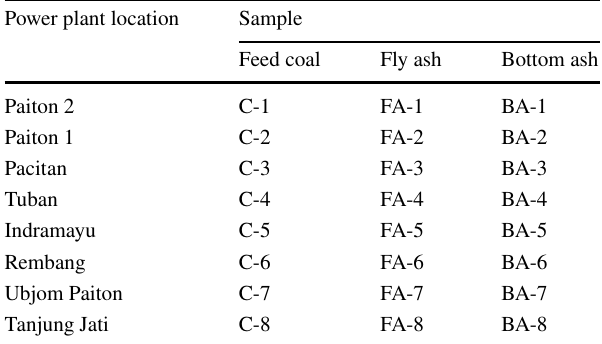
Fig. 2 Location of eight coal-fired power plants in northern Java, Indonesia. Coal and FABA samples were taken from the power plants (Map data: Google, accessed 14 February 2022) Table 1 List of samples collected from 8 power plants in Java, Indo- nesia Power plant